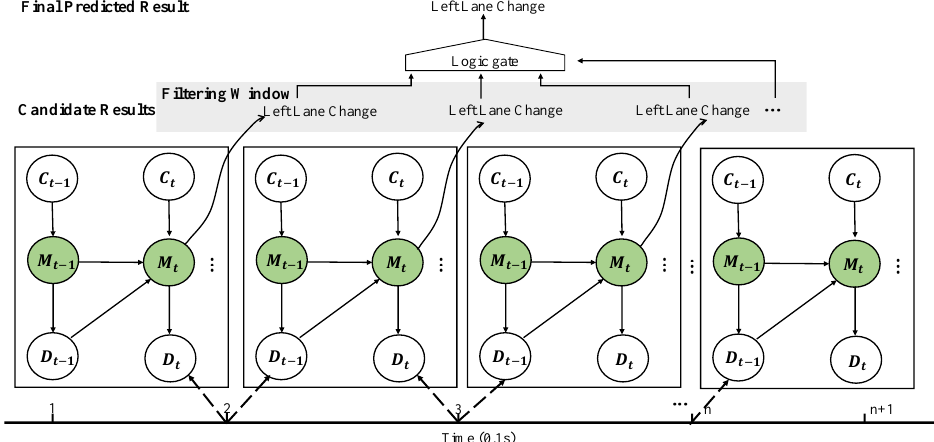
Figure 6. The workflow of window filtering